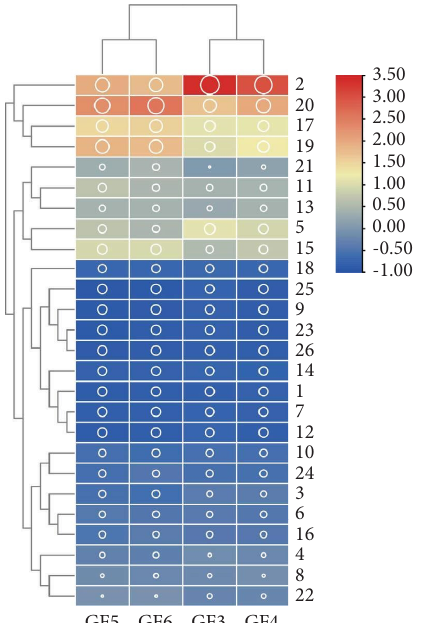
Figure 6: Heatmap and dendrogram of HCA of peak intensity of GFs of various ages. It is normalized for column scale; the size of the circle represents the size of the peak intensity; colors from red and yellow to blue represent the peak intensity of compounds from bigger to